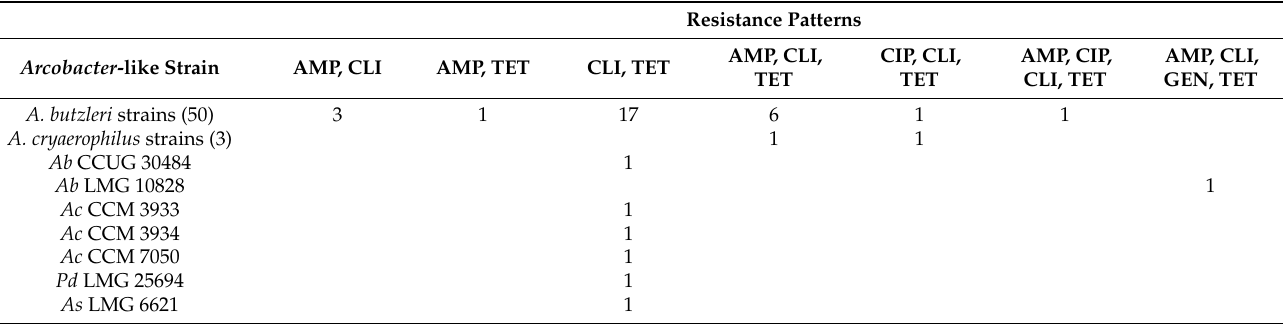
Table 2. Multi-drug resistance of Arcobacter -like